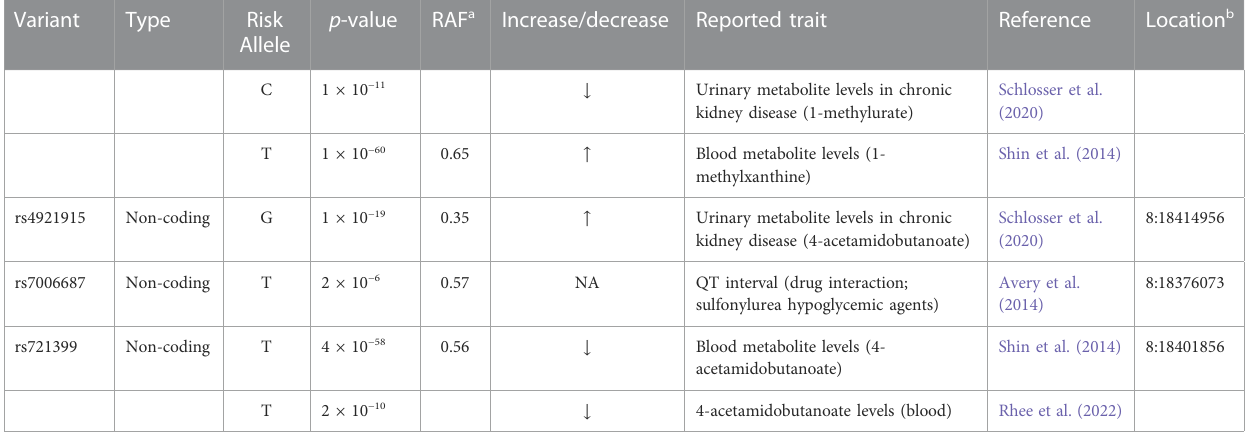
TABLE 3 Seven-variant dyslipidemia haplotype in